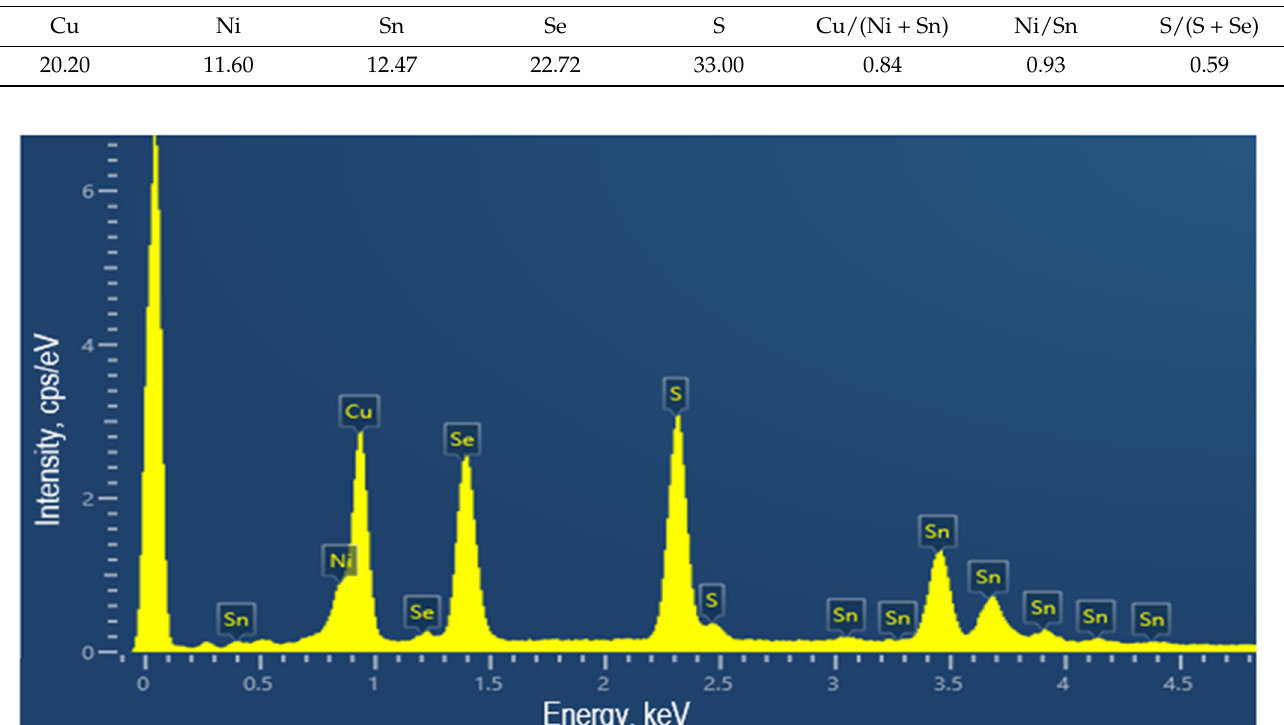
Table 1. The elemental composition and atomic ratio of the CNTSSe thin films. Elemental Composition, at.%